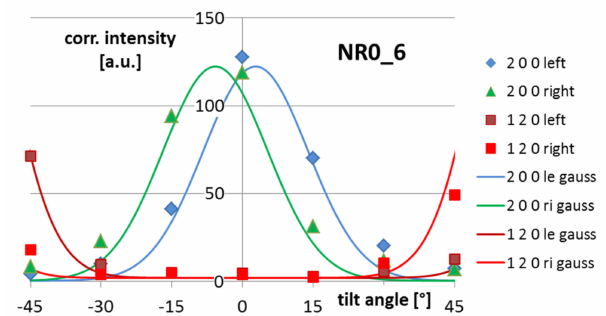
Figure 7. Intensities of the crystalline peaks of the sample NR0 with a stretch ratio of 6:1 in dependence of sample rotation, measured values (symbols) and values of the model (continuous lines) in analogy to Figure